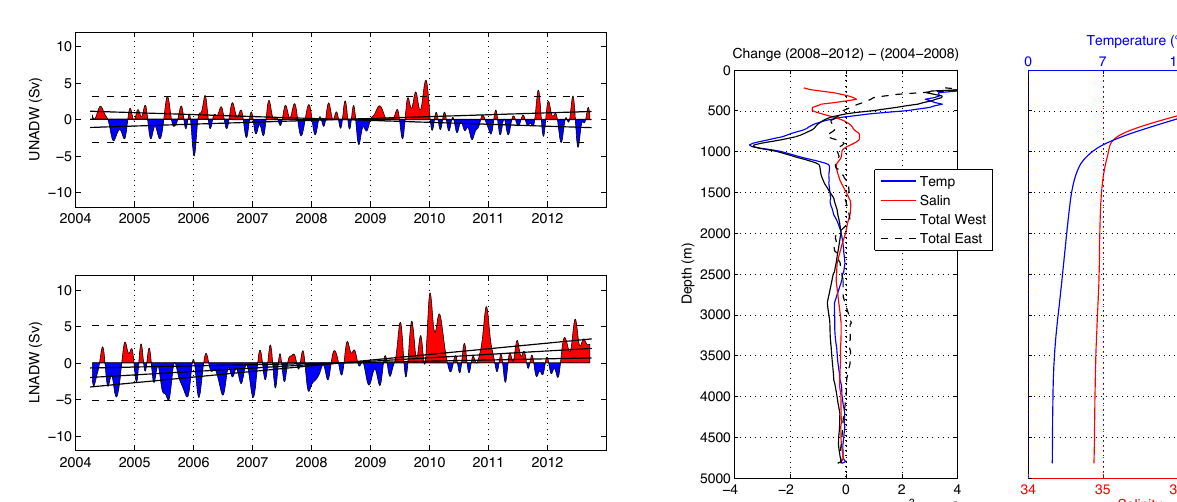
Fig. 6. Left: mean density difference (black) between the two four-year periods: April 2004 to March 2008 and April 2008 to March 2012. Continuous line shows the change on the western boundary and dashed shows the change on the eastern boundary. Also shown is that part of the density change on the western bound- ary due to temperature (blue) and that due to salinity (red). Left: mean temperature (blue) and salinity (red) profiles on the western boundary of the 26 ◦ N